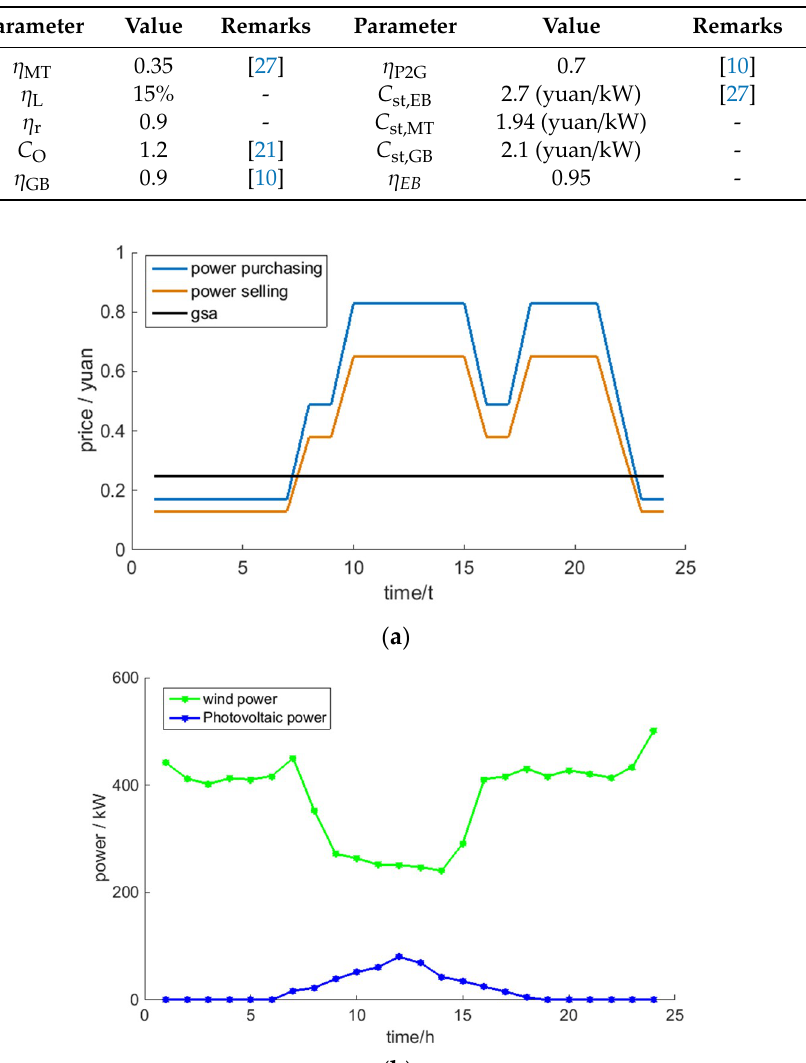
Figure 2. ( a ) Power price and gas price; ( b ) Wind and photovoltaic forecasted power. 368